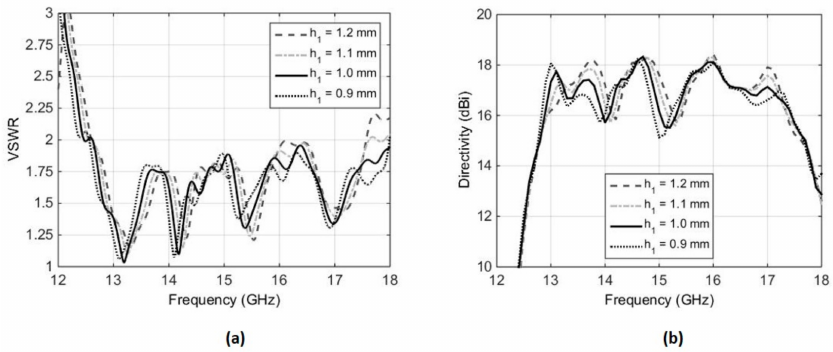
Figure 5. Sensitivity of air-gap h 1 with respect to VSWR and broadside directivity of the RCA, ( a ) VSWR, ( b ) broadside directivity.